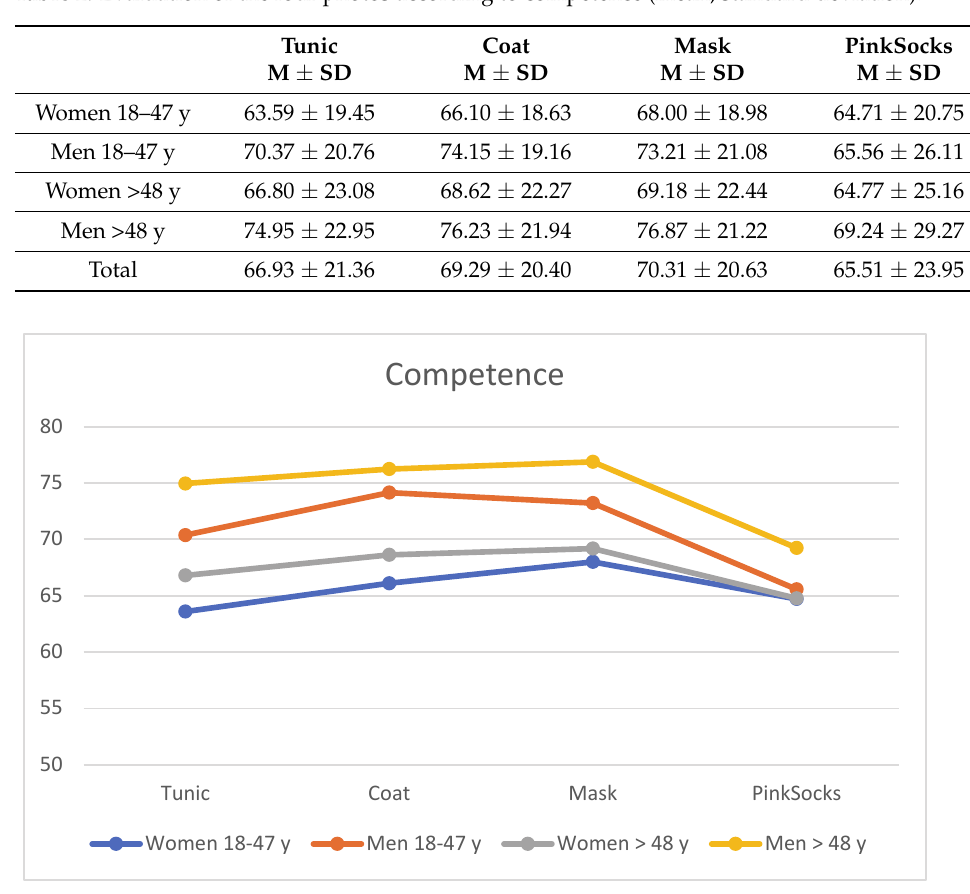
Figure 4. Mean rating of the four photos for competence by the four subgroups ( n = 906).